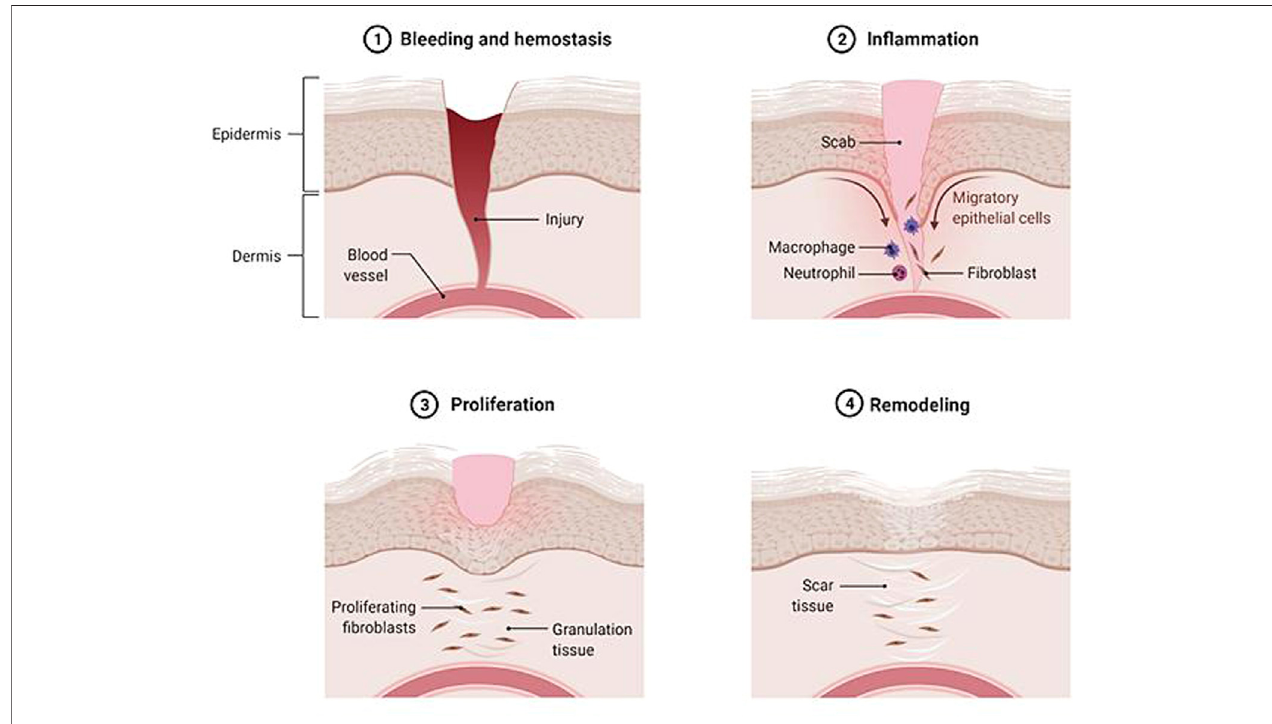
FIGURE 1 | Wound healing performance. The closure of wound occurs in four overlap steps: hemostasis, in fl ammation, proliferation, and remodeling.